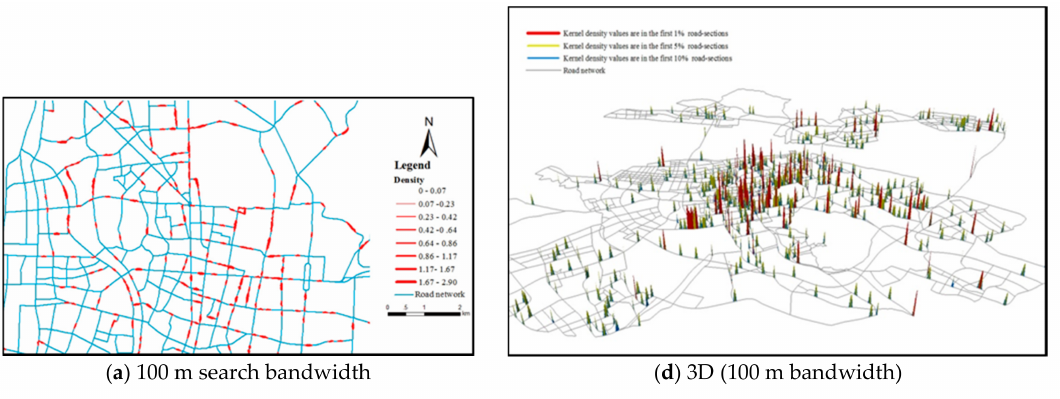
Figure 11. The results of network kernel density in different intervals.